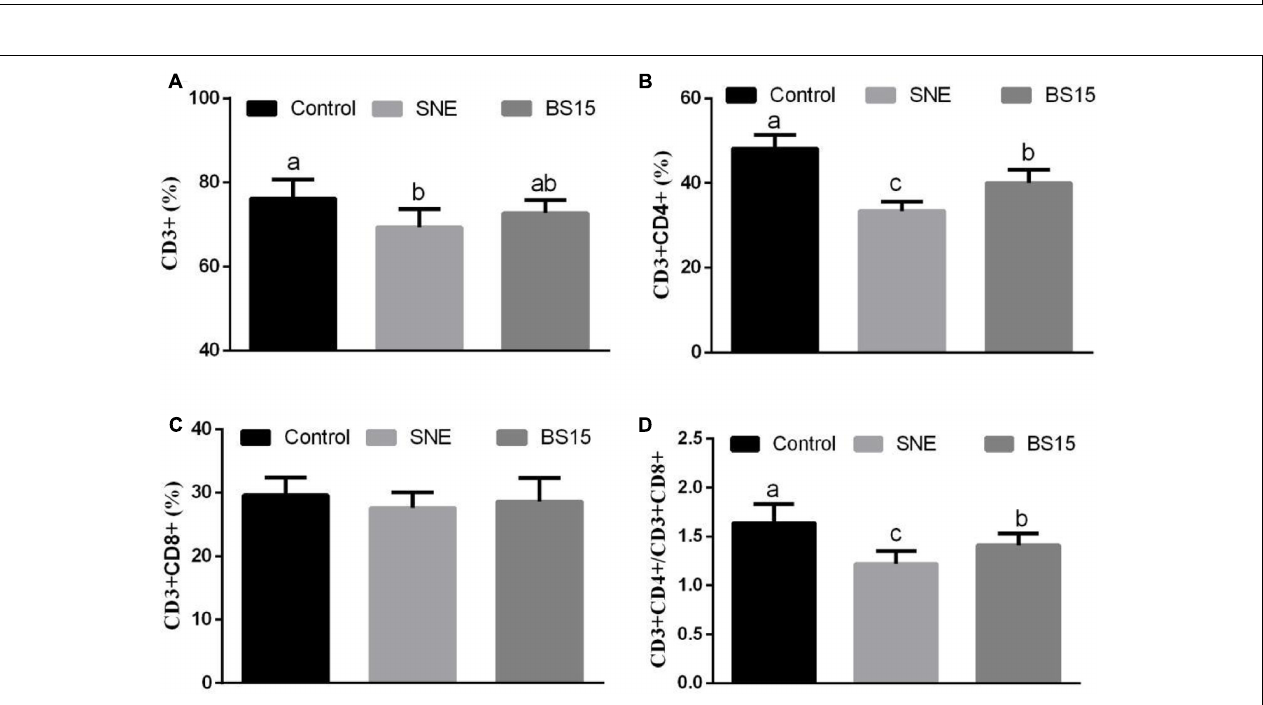
FIGURE 7 | CD3 + (A) , CD3 + CD4 + (B) , CD3 + CD8 + (C) , T-lymphocyte percentages and CD3 + CD4 + /CD3 + CD8 + ratio (D) in the peripheral blood (Experiment 2). Bars with different letters are significantly different on the basis of Duncan’s multiple range tests ( P < 0.05). Data are presented as mean ± standard deviation (six replicates of one chick per cage).